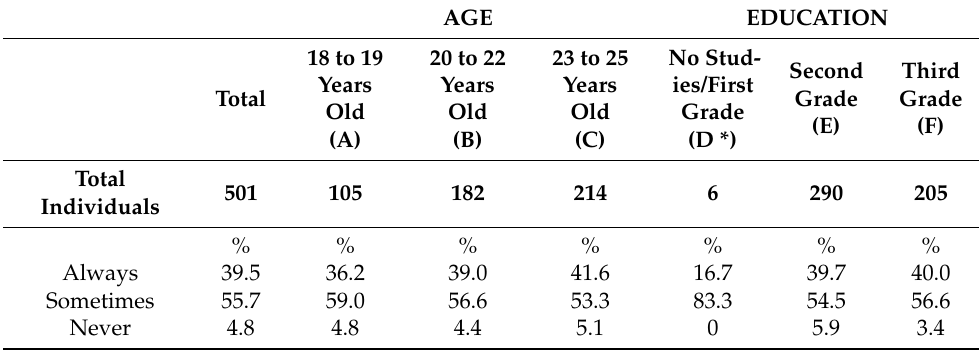
Table 11. Question 6: Do you check whether the news you read is true or